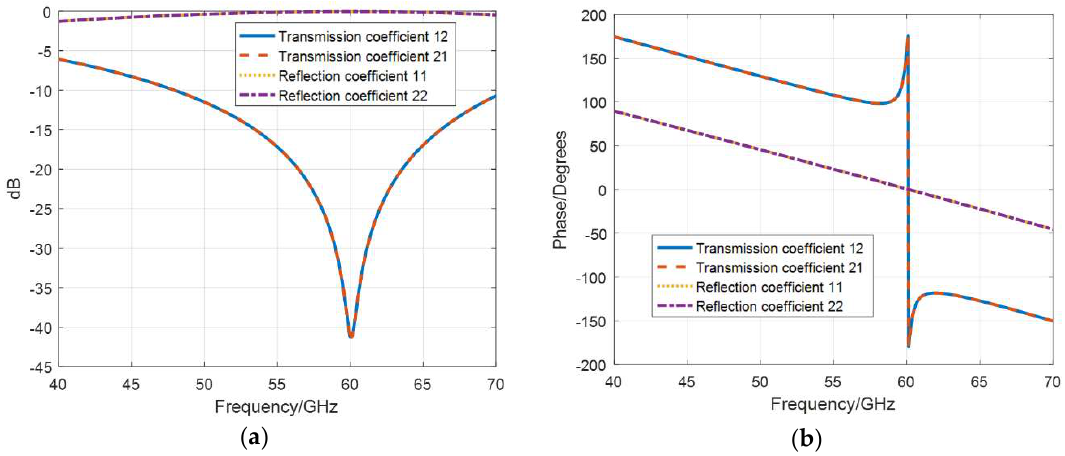
Figure 4. Simulated plots of magnitude and phase of the 60-GHz flexible metasurface: ( a ) Reflection and transmission coefficients plots, ( b ) Phase of the reflection and transmission